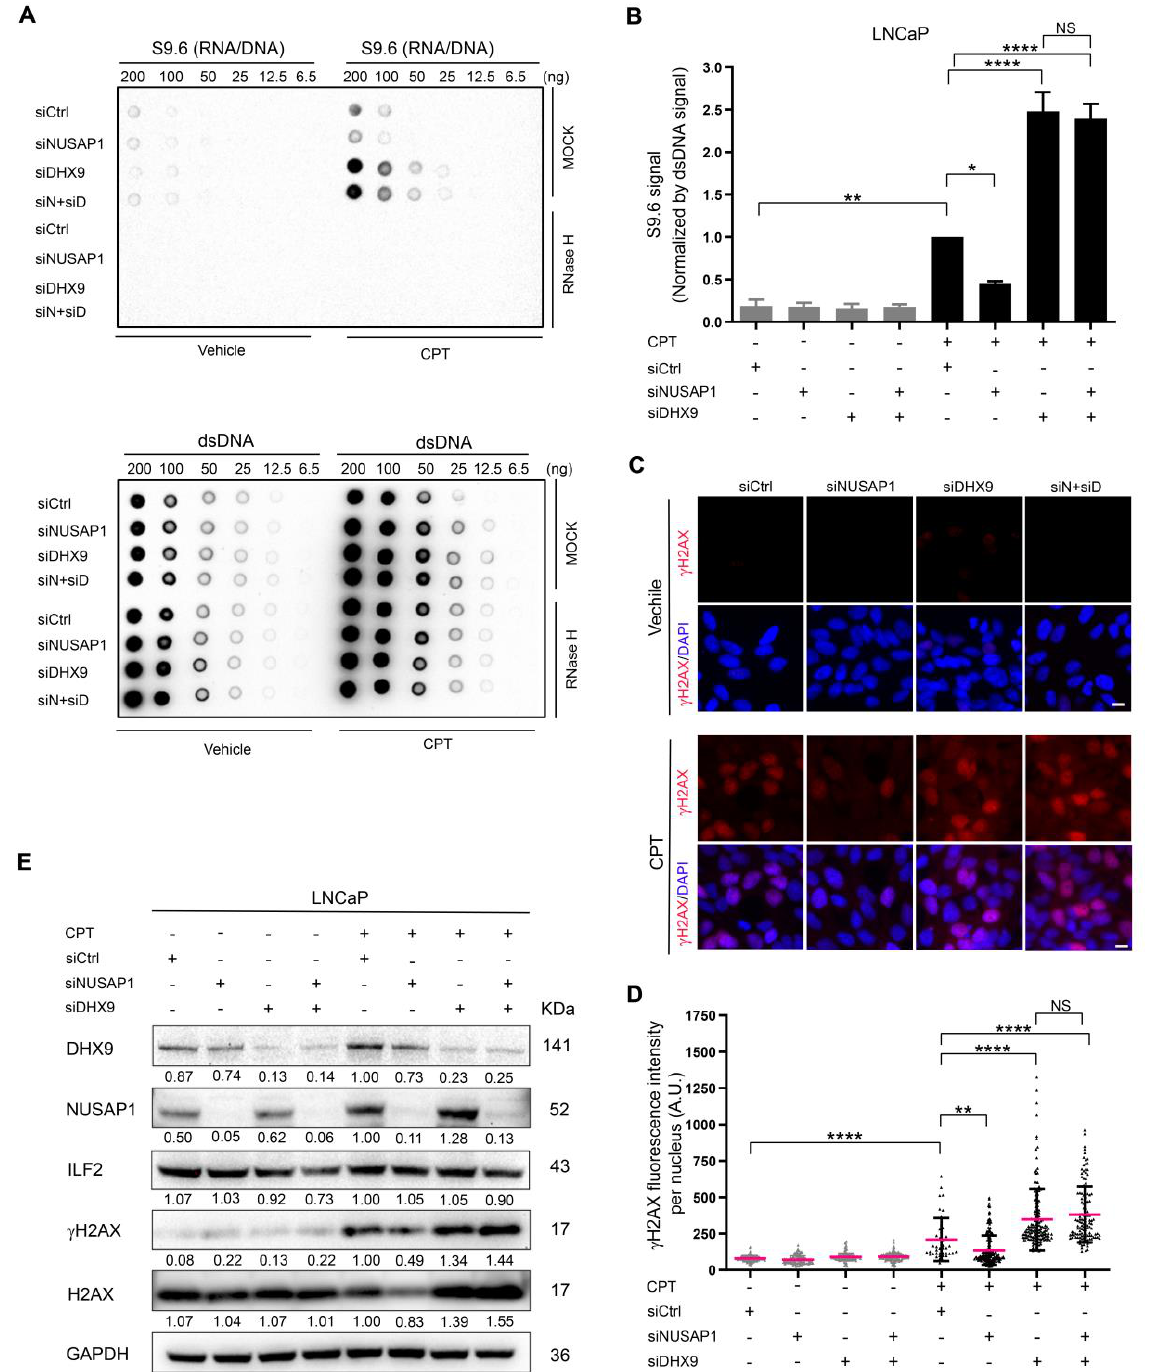
Figure 4. NUSAP1 depletion reduces CPT-induced R-loop accumulation and DNA damage and DHX9 depletion increases both. ( A ) Dot-blot analysis of R-loop levels in LNCaP cells without and with 10 µM Camptothecin (CPT) treatment for 60 min after 48 h post-transfection of siNUSAP1, siDHX9, or both. Serial dilutions of RNA/DNA hybrids (R-loops) and dsDNA extracts were spotted on the membrane for each condition. R-loop formation was increased with CPT treatment. siNUSAP1 alone reduced R-loop levels, while siDHX9 significantly increased R-loops. siDHX9 and siNUSAP1 together did not reduce the accumulation of R-loops compared to siDHX9 alone. Bottom panels anti- DS DNA antibody serves as loading control. ( B ) S9.6 signal from the dot-blots in the 100 ng nucleic acid samples normalized by dsDNA signal quantified using Image J ( n = 3). ( C )